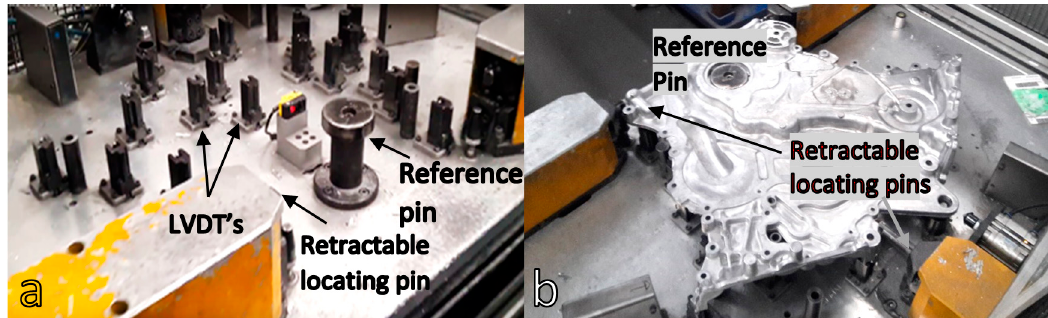
Figure 5. Current gaging inspection system: ( a ) View from operator’s perspective showing linear variable displacement transducers (LVDTs) and reference pins, and ( b ) view from the opposite side showing a workpiece mounted and ready for measurement operation.